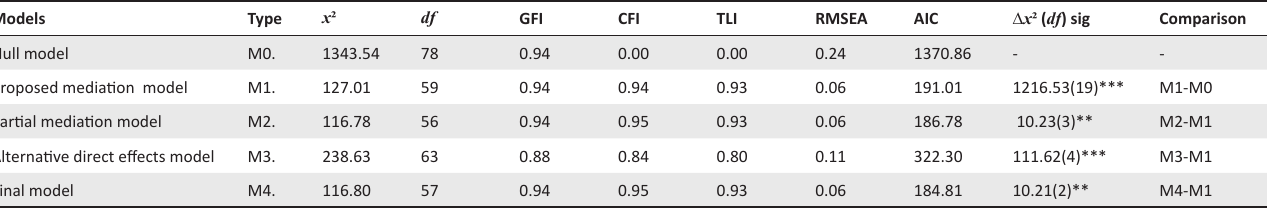
TABLE 2: Fit indices and comparisons of alternative models for integrating psychosocial safety climate (PSC) in the JD-R Model.